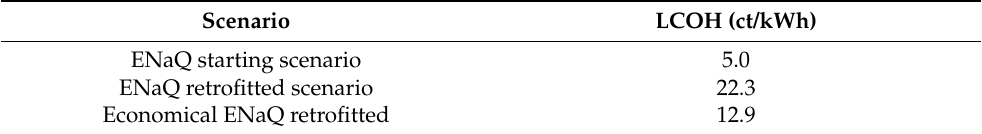
Table 8. Levelized cost of heat for ENaQ starting, retrofitted and economical ENaQ retrofitted